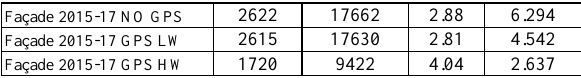
Table 4. Planar dataset: stats on collinearity residuals. Dataset (planar)